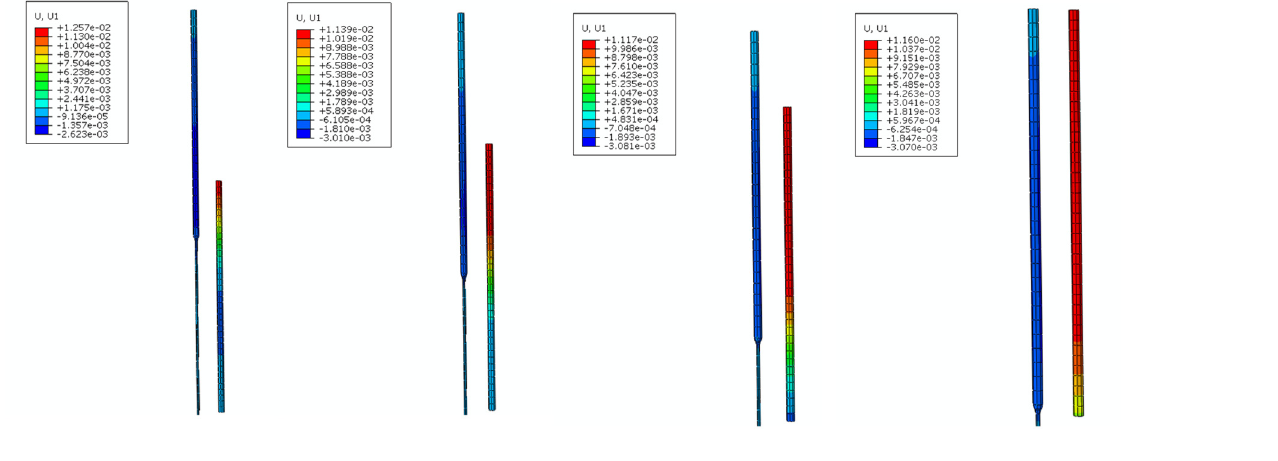
Figure 8. Nephogram of existing pile lateral displacement caused by new pile penetrating to different depths.